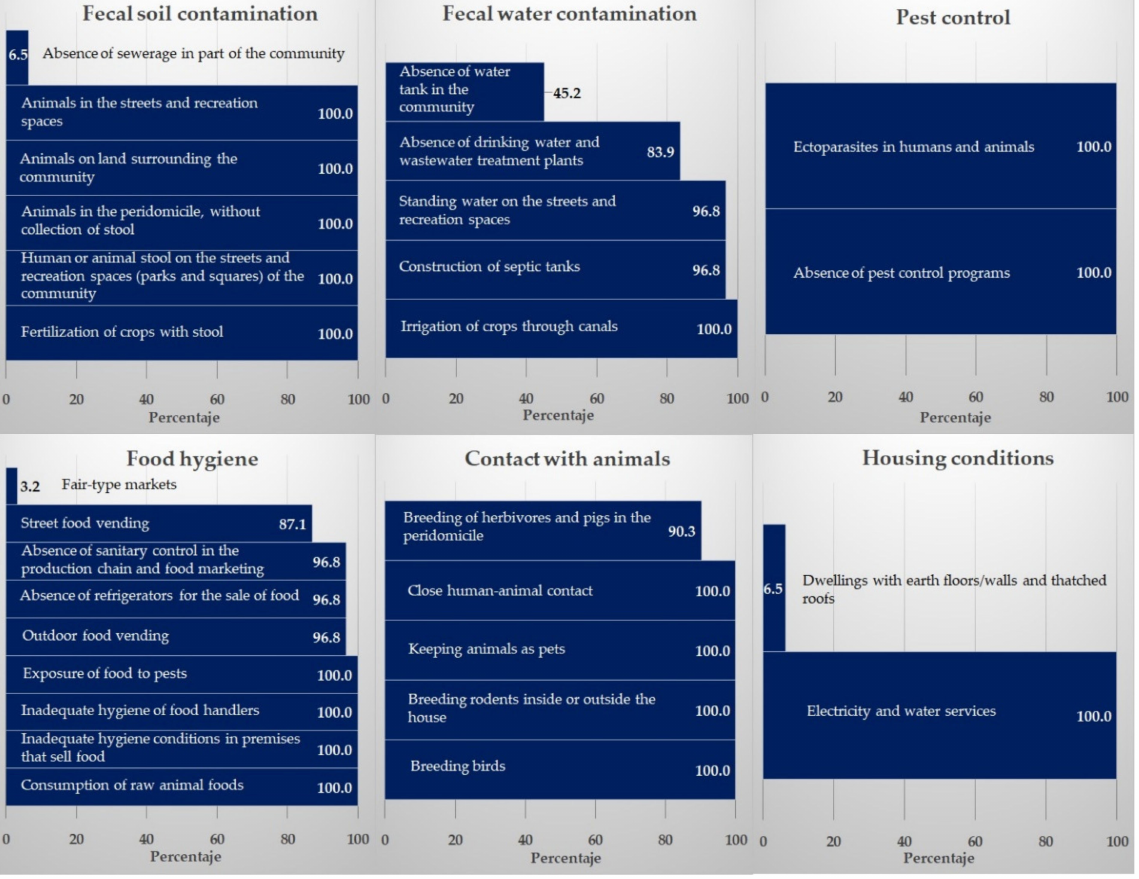
Figure 8. Risk factors associated with the transmission of intestinal parasites in San Andres. mined: soil fecal contamination (0.84 ± 0.042) and water (0.85 ± 0.106); absence of pest control (1 ± 0); inadequate food hygiene (0.87 ± 0.055); contact with animals (0.98 ± 0.073); and inadequate housing conditions (0.53 ± 0.105), with an overall arithmetic mean of 0.85 ± 0.069. These results indicate that the risk variables have an influence of 85% as a transmission risk index, demonstrating the critical hygienic situation of the